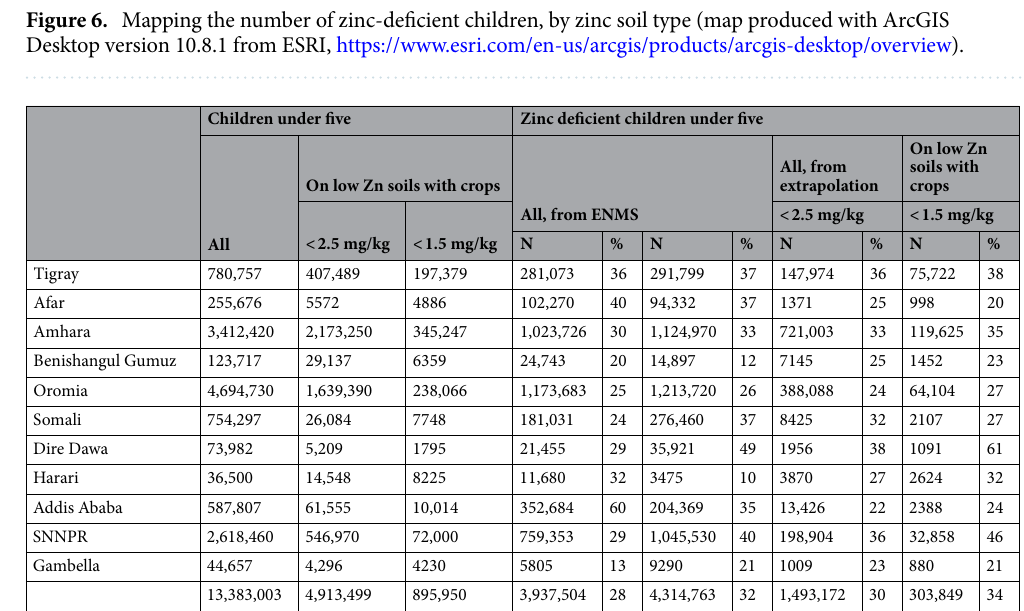
Table 2. Number of children under five years of age, total and zinc deficient, living on zinc deficient and low zinc soils, by region.